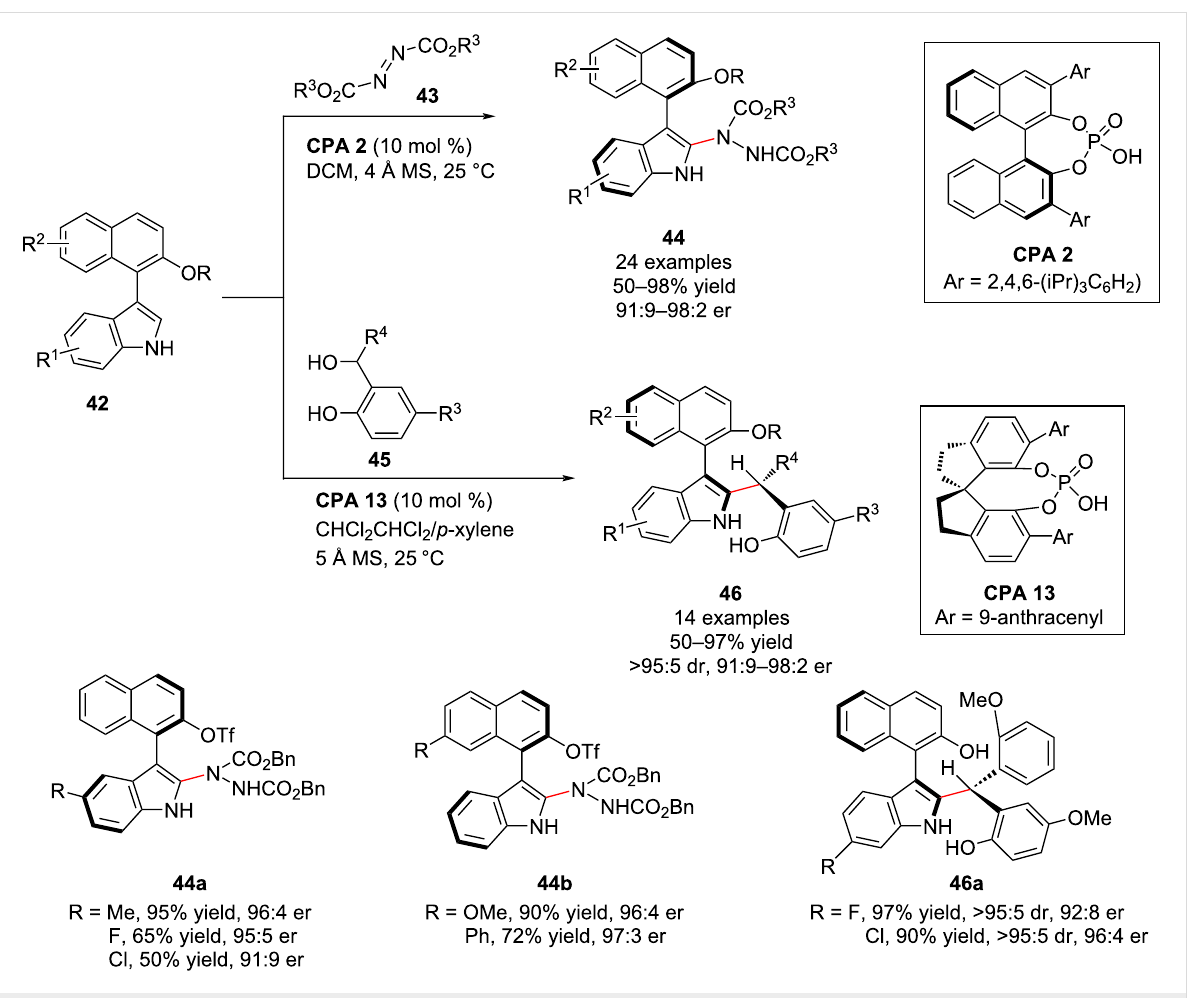
Scheme 15: Asymmetric construction of axially chiral naphthylindoles